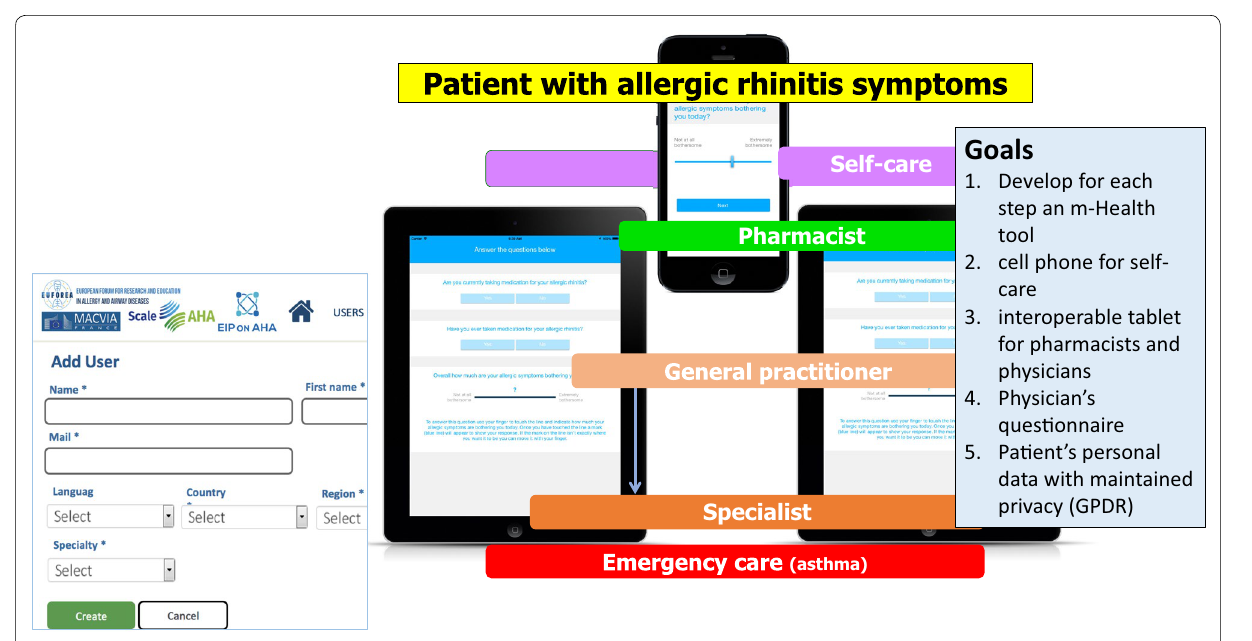
Fig. 2 ICT solutions embedded in care pathways for chronic respiratory